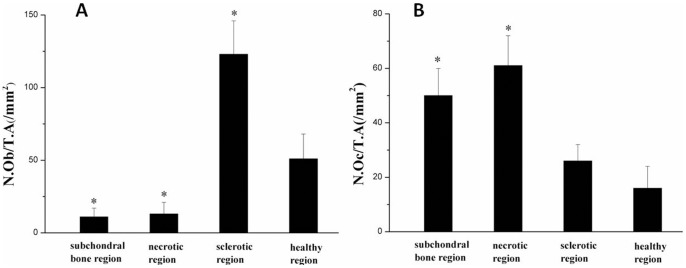
Quantitative analysis of the number of osteoblasts and osteoclasts.(A) The number of osteoblasts per unit tissue area in the subchondral bone, necrotic, sclerotic and healthy regions (N.Ob/T.A mm2); (B) The number of osteoclasts per unit tissue area in the subchondral bone, necrotic, sclerotic and healthy regions (N.Oc/T.A mm2) * P < 0.05 compared with the healthy region.